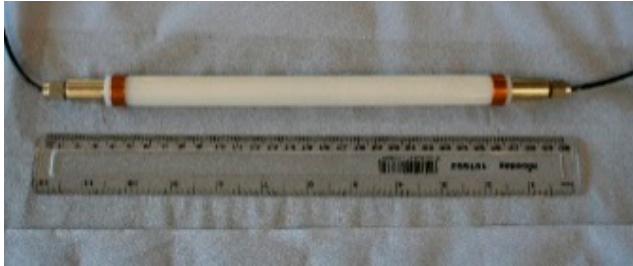
Figure 1. Commercial optical fiber